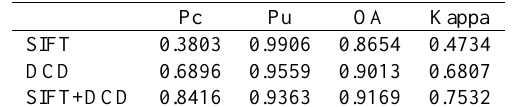
Table 1. The comparison of change detection results generated by “the predictive mean” for different superpixel descriptors.